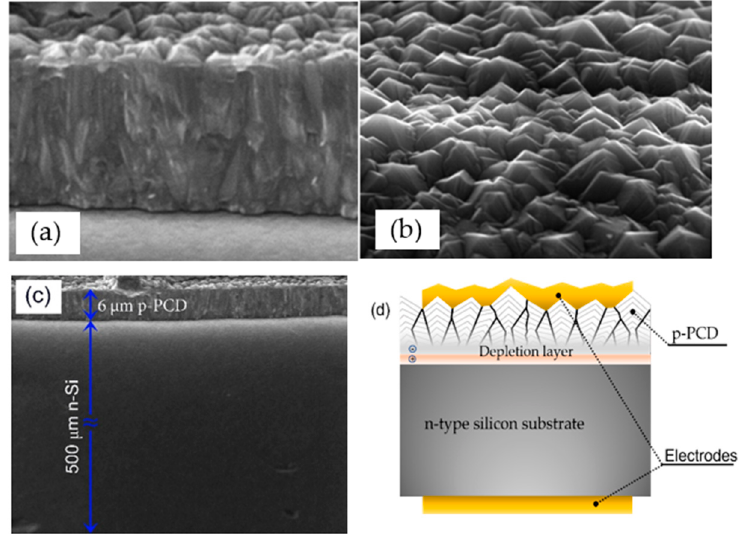
Figure 1. SEM images analysis of ( a ) cross-section of the diamond layer, ( b ) the surface morphology, ( c ) cross section of p-PCD/n-Si heterojunction, and ( d ) a two-dimensional schematic cross section of the heterojunction.